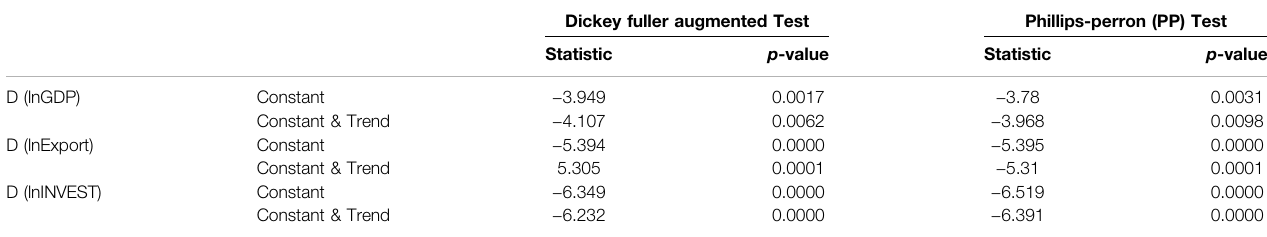
TABLE 5 | Root testing of lagged variables by ADF and PP units.